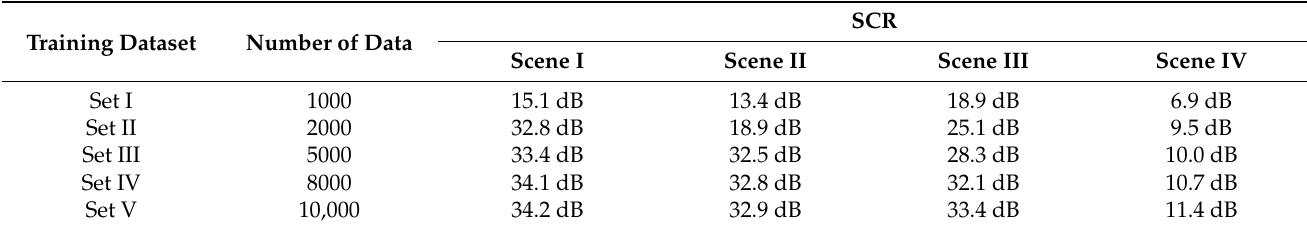
Table 2. SCR of the proposed method with different amounts of training